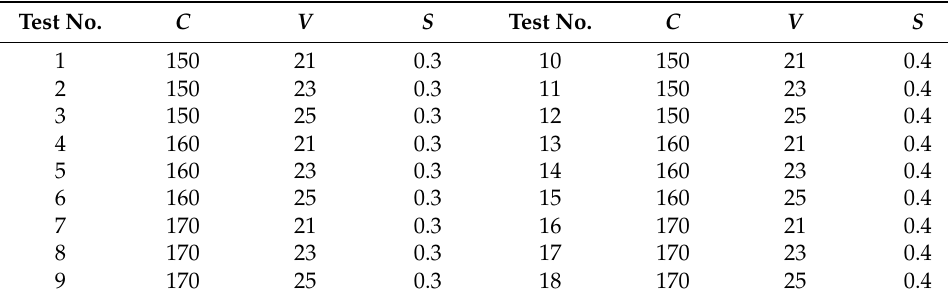
Table 4. Experimental plan of flux cored arc welding process [7]. Test